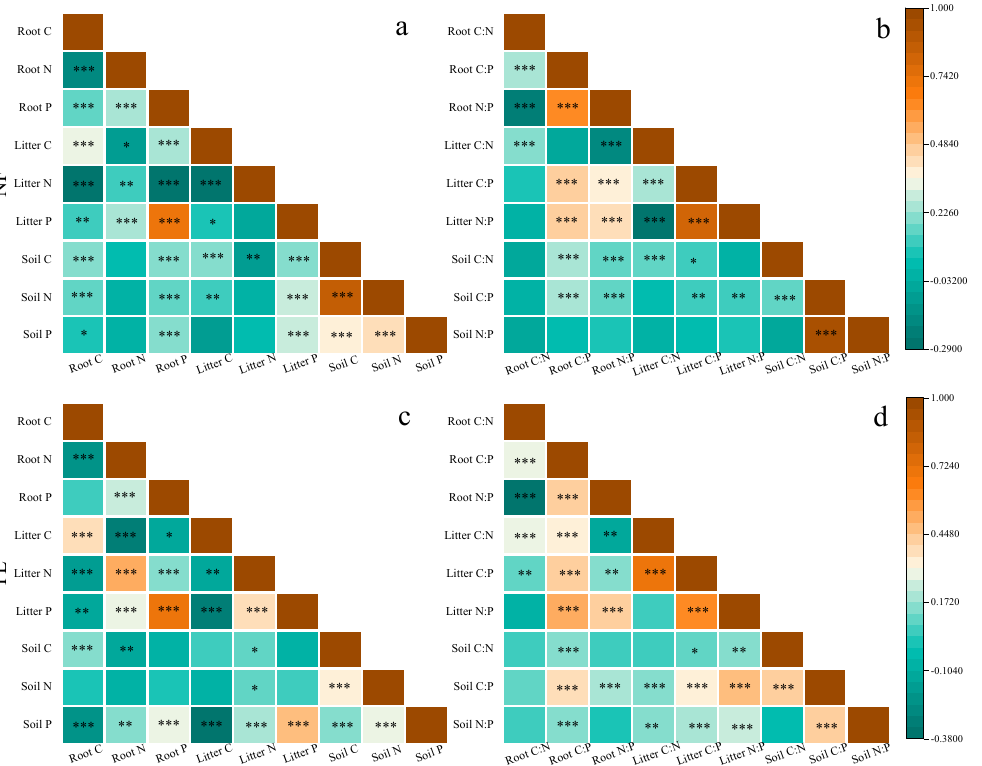
Figure 4. Pearson’s correlation matrix between plant root, litter and soil C, N and P concentrations and stoichiometric ratios in NF and PL. ( a , b ) The correlation between the concentrations of C, N and P and the stoichiometric ratios of C:N, C:P and N:P in roots, litter and soil in NF; ( c , d ) the correlation between the concentrations of C, N and P and the stoichiometric ratios of C:N, C:P and N:P in roots, litter and soil in PL. * p < 0.05, ** p < 0.01,*** p < 0.001.